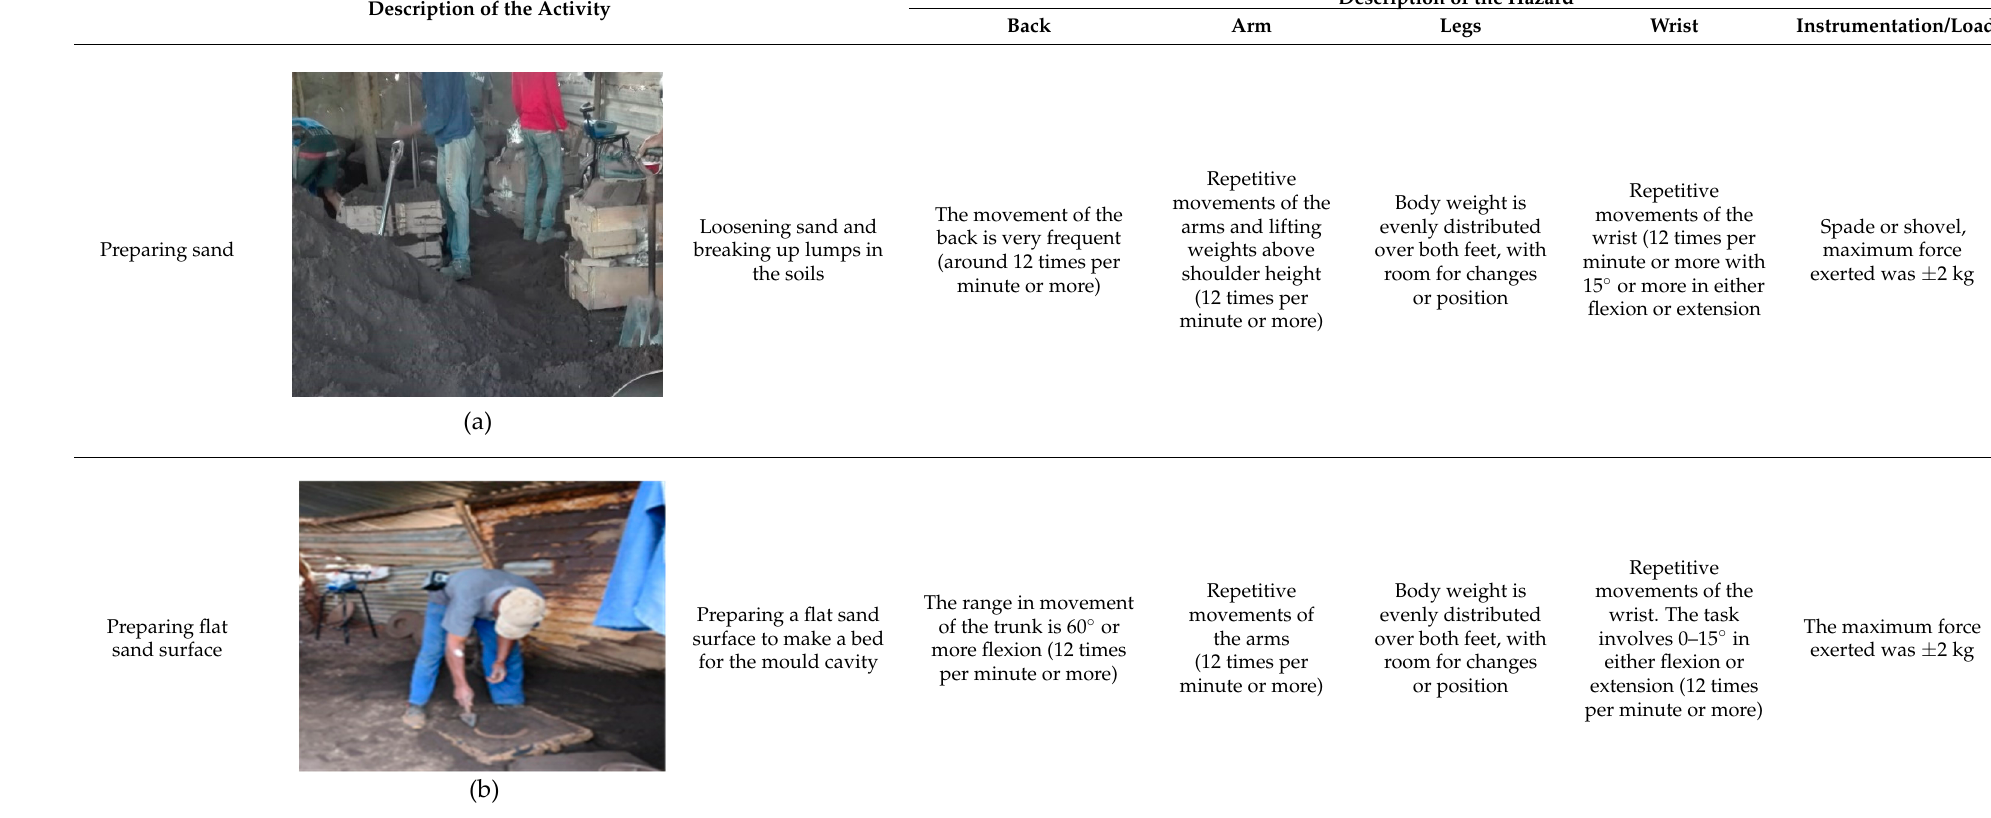
Table 2. Description of the tasks and ergonomic hazards.